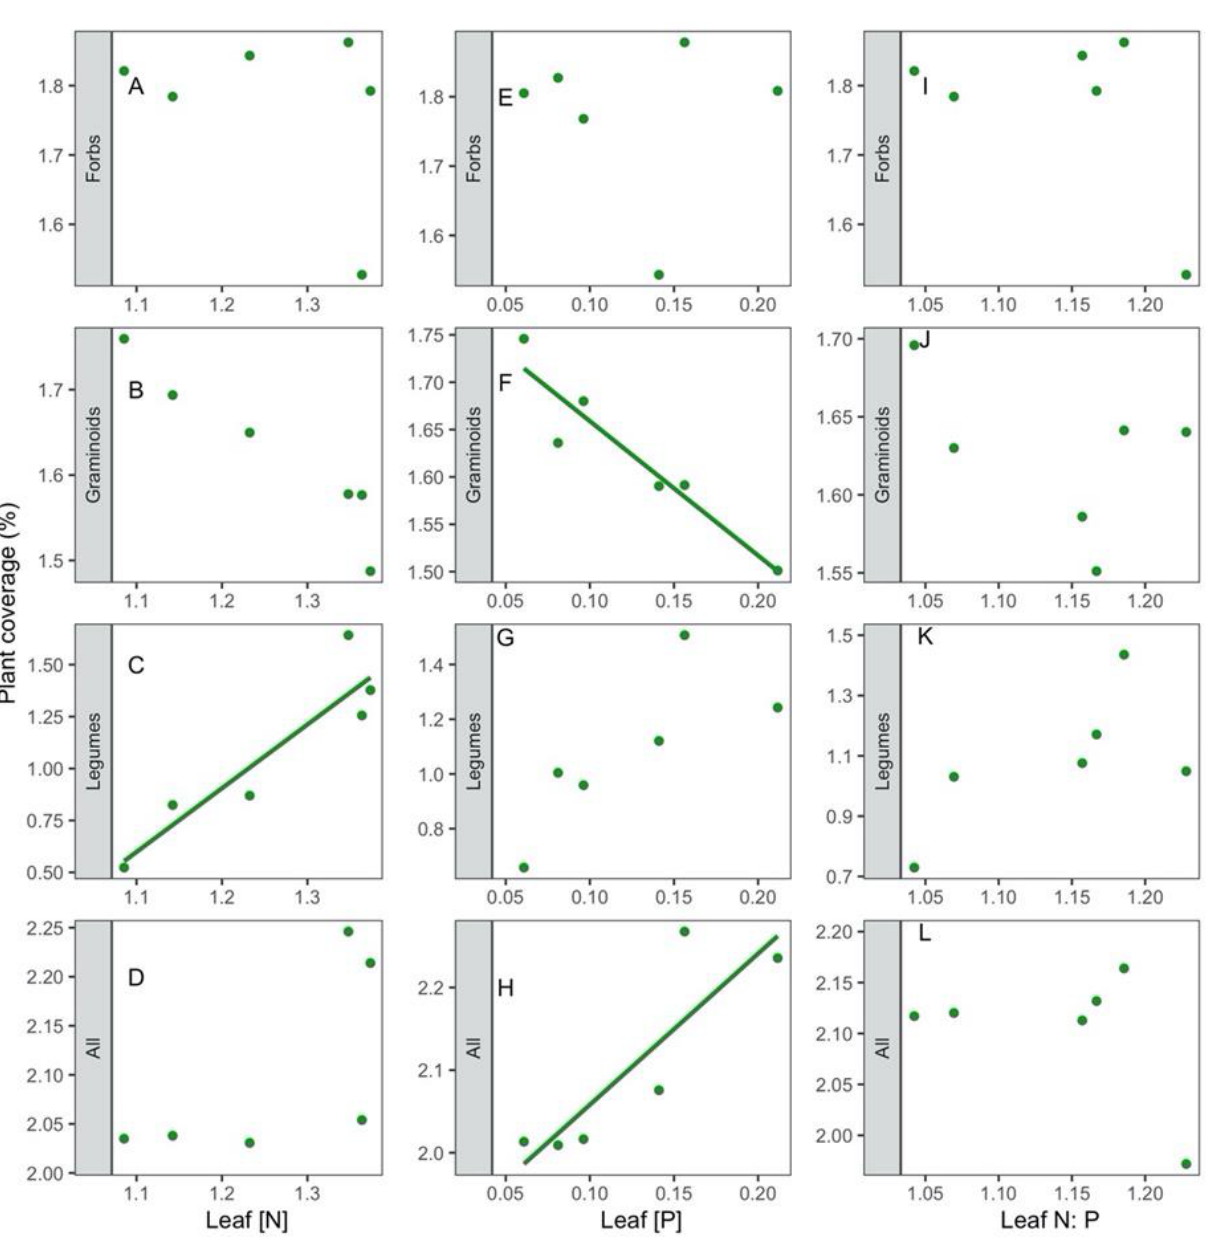
Figure 6. Correlations of species coverage of each plant functional group and the whole community with leaf N concentration ( A – D ), with leaf P concentration ( E – H ), and with leaf N:P ratio ( I – L ). Variables are log10-transformed.